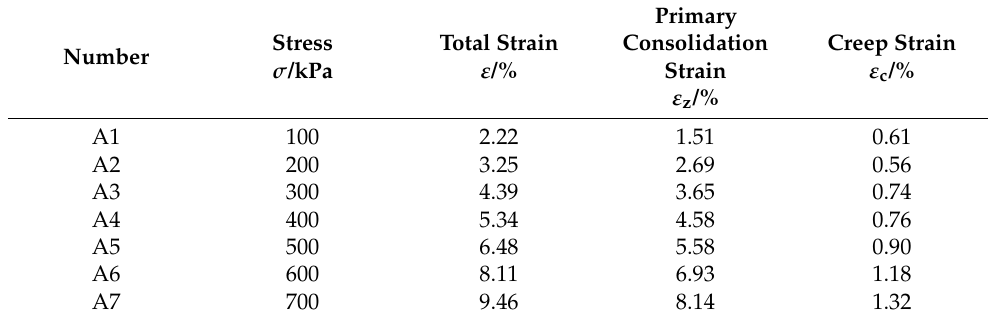
Table 4. Strain of sandy soil under different vertical loads.